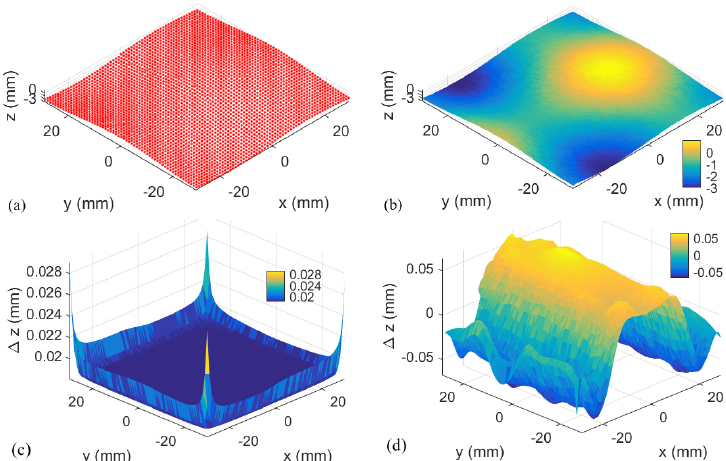
Figure 19. Measurement data and Gaussian process result: ( a ) raw data of measurement with the laser sensor; ( b ) mean surface; ( c ) associated uncertainty for the laser sensor; and ( d ) deviation of the mean surface from the reference data.